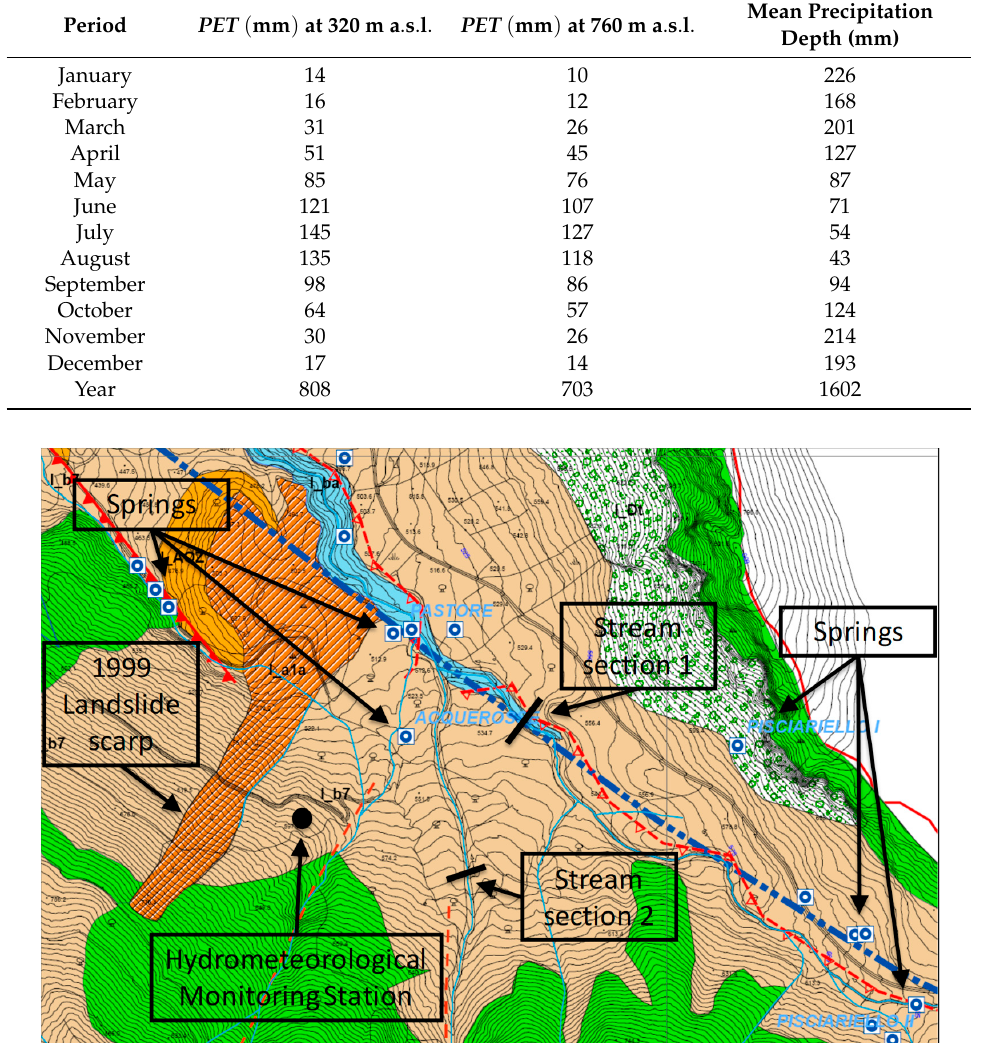
Figure 2. Hydrogeological map of the slope of Cervinara, with indication of the monitoring station, the main springs, and the scarp of the main landslide of 16 December 1999.